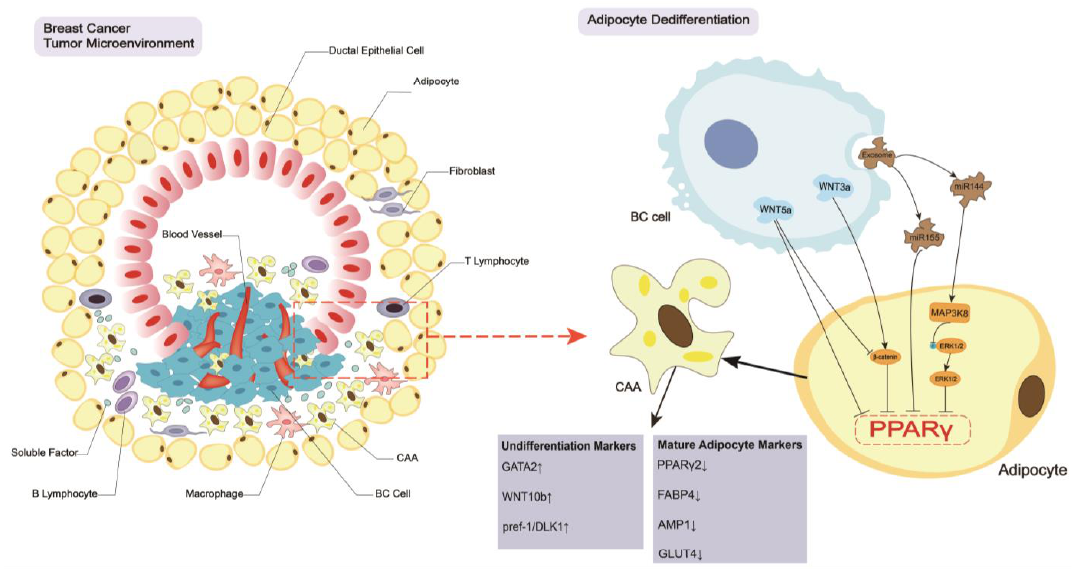
Figure 1. Dedifferentiation of adipocytes in the breast cancer TME. There are many components in the TME, including adipocytes, BC cells, CAAs, T lymphocytes, B lymphocytes, macrophages, small vessels, ductal epithelial cells, fibroblasts, and many soluble factors. Adipocytes adjacent to BC cells dedifferentiate and form CAAs via the inhibition of PPAR γ by BC secretions, such as WNT proteins and exosomes. CAAs have an irregular shape and are filled with tiny distributed lipid droplets. Undifferentiation markers in CAAs (WNT10b, Pref-1/DLK1, and GATA2) increase, and mature adipocyte markers (PPAR γ 2, FABP4, APM1 and GLUT4) decrease. Abbreviations: BC, breast cancer; CAAs, cancer-associated adipocytes; TME, tumor microenvironment; miR144, microRNA 144; miR155, microRNA 155; PPAR γ , peroxisome proliferator-activated receptor gamma; ERK1/2, extracellular-regulated kinase 1/2; MAP3K8, mitogen-activated protein kinase kinase kinase 8; GATA, GATA binding protein; WNT, wingless-related integration site; pref-1, preadipocyte factor 1; DLK1, delta-like 1 homologue; FABP4, fatty acid binding protein 4; AMP1, adenosine monophosphate 1; GLUT4, glucose transporter